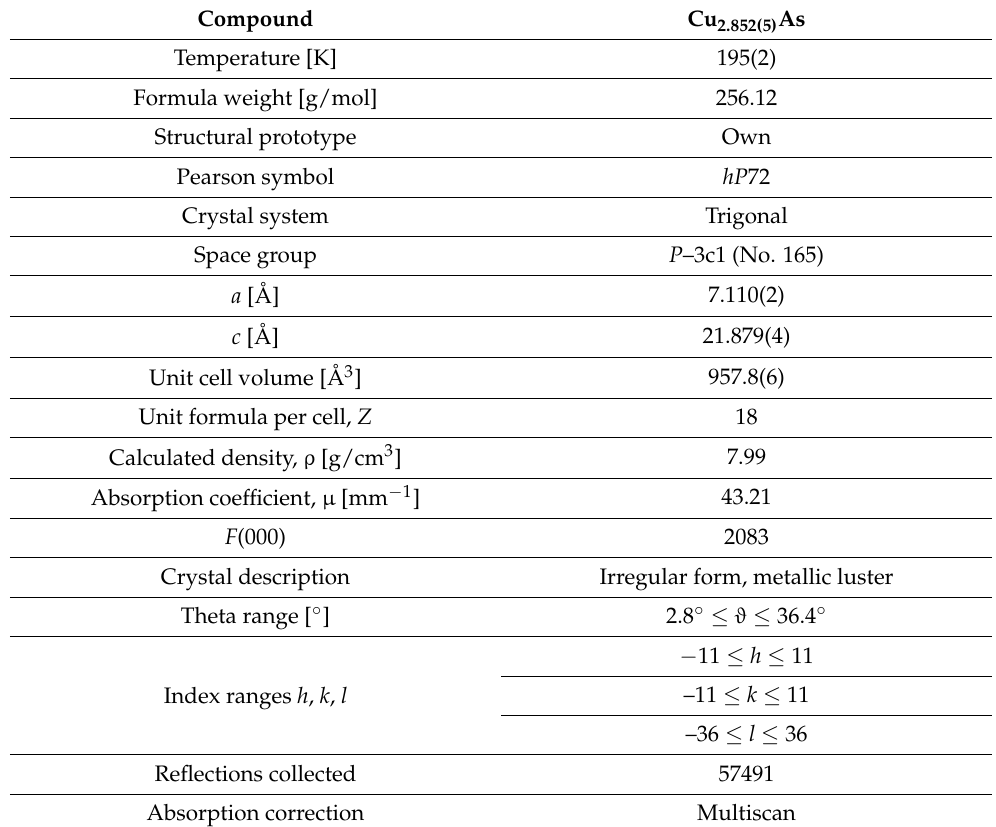
Table 6. Crystal data and structure refinement details for the LT-Cu 3 − x As